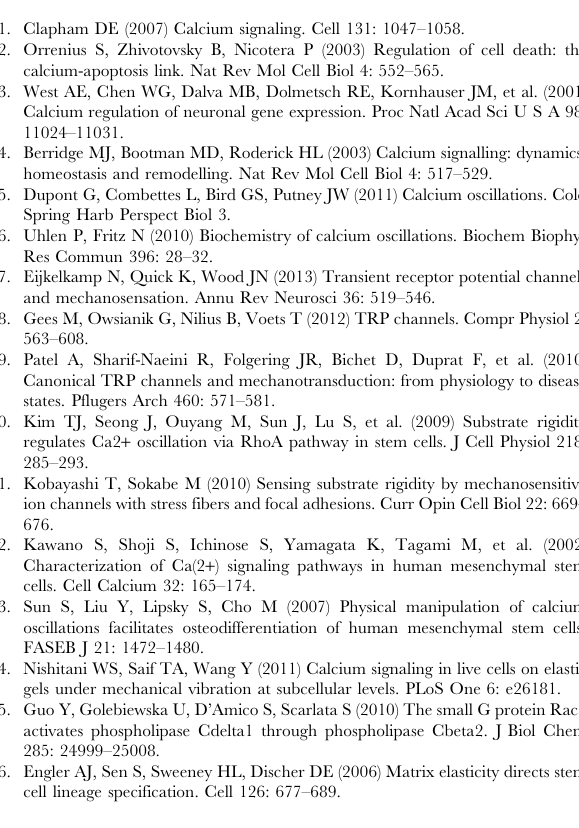
Figure S2 Calcium signals in response to PMS and unloading. hMSCs showed the PMS-induced calcium signals, but when stretch stopped, calcium oscillations disappeared (n= 3, Loading vs Unloading,** P , 0.01). Figure S3 Spontaneous calcium oscillations (n= 33) have similar frequency as PMS-induced calcium oscillations (n= 9). There is no statistical